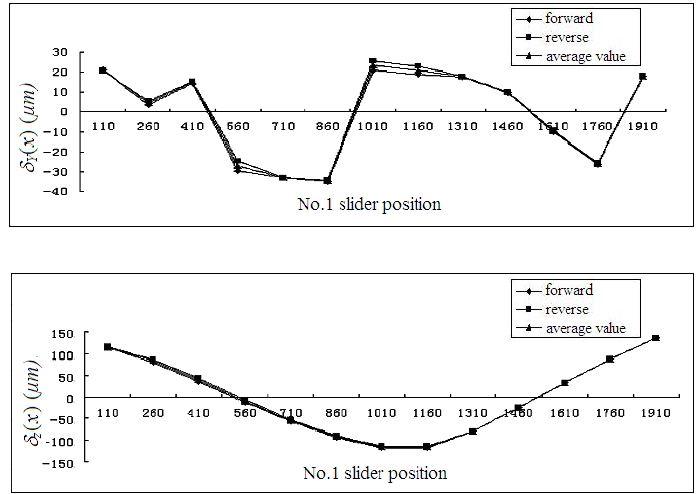
Figure 9. Straightness motion error of slider 1. Table 3. Error contributed by straightness motion errors.